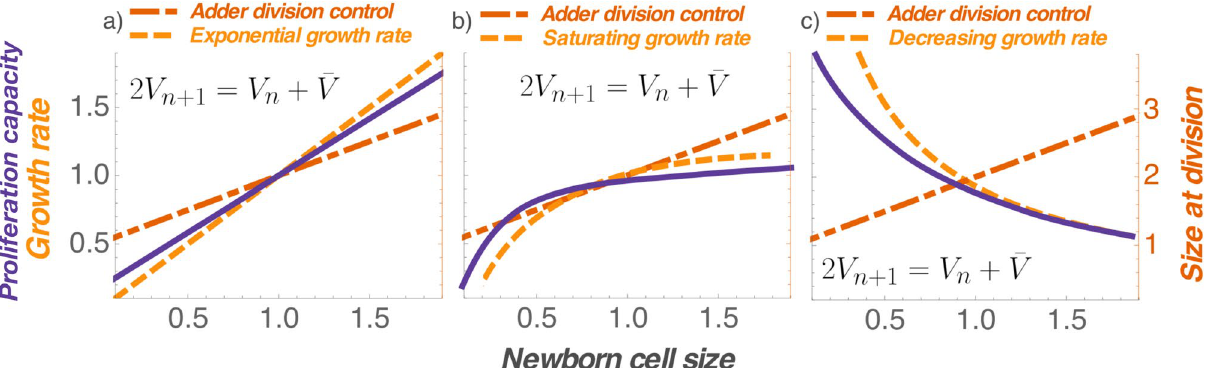
Figure 2. Monotonic growth rates coupled with Adder-based division control yield monotonic proliferation capacity profiles. Exponential growth ( a ), or an increasing growth rate followed by saturation ( b ) together with the Adder model always lead to a proliferation capacity monotonically increasing with size. In contrast, a decreasing growth rate together with an Adder yields a decreasing proliferation capacity ( c ). Newborn cell size (x axis) is normalized by its mean. Proliferation capacity, growth rate, and size at division (y axes) are normalized by their corresponding values for the mean newborn size. The proliferation capacity for the exponential growth case is computed by solving the equations (21)–(23) from the “Methods” section. In the saturating growth rate case, proliferation capacity is calculated using (24), (22), and (23) from the “Methods”